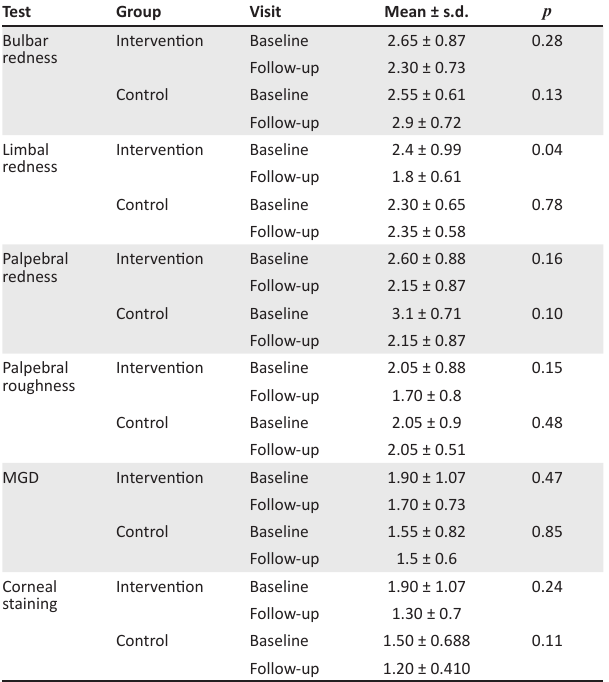
TABLE 3: Group means and standard deviations for clinical variables graded with the Efron scale for baseline and follow-up visits for both the intervention and control groups, together with Wilcoxon paired-test intergroup